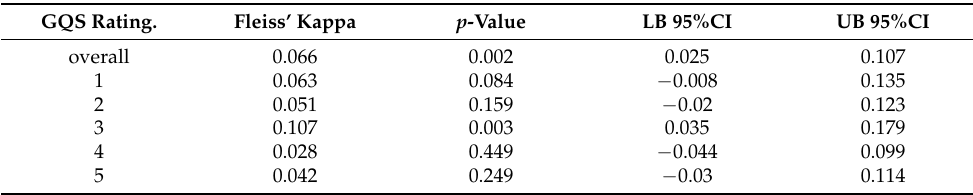
Figure A2. Dislikes were plotted on a log scale due to the typical distribution of this variable. When plotted against the GQS of the corresponding video, an almost horizontal line emerged. A similar picture appears for all other combinations of Likes, Dislikes and Views vs. the quality scores employed in this study. Table A1. Fleiss’ Kappa estimated in order to assess rater agreement was determined to be poor in this data set both overall and for each individual value of GQS. GQS Rating.